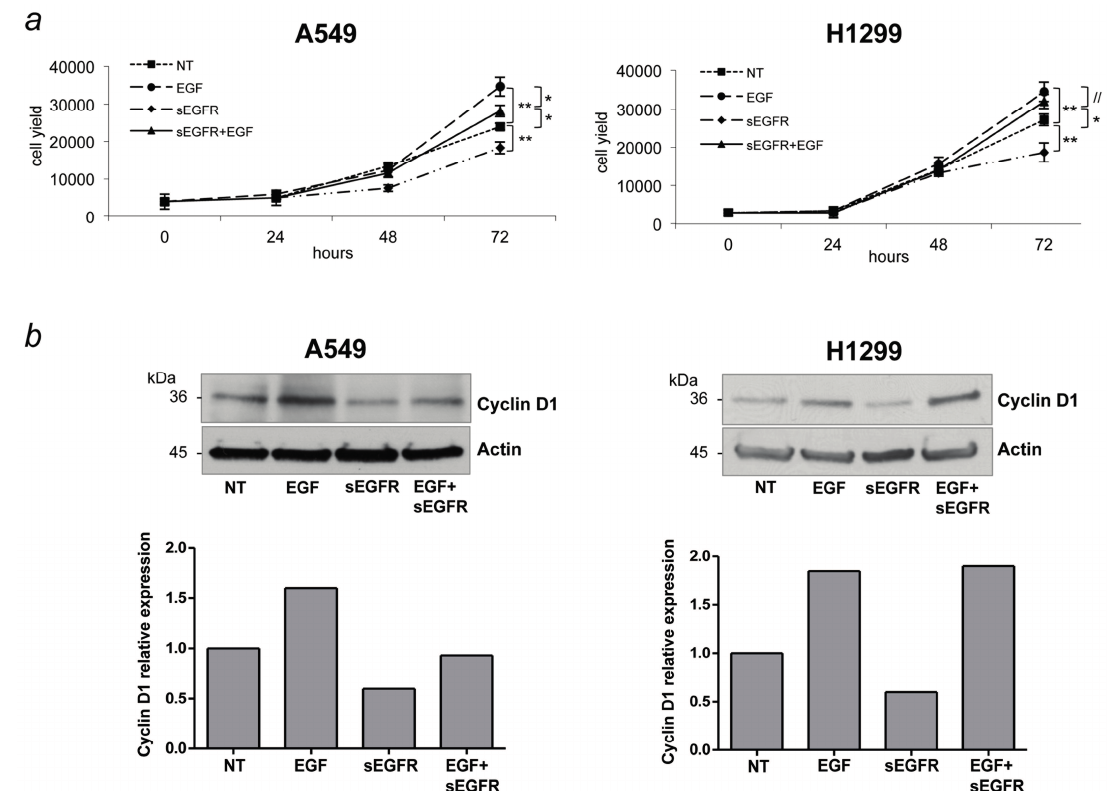
Figure 3. Effects of combined treatment with sEGFR and EGF on cell proliferation. EGFR-wild type cell lines (A549 and H1299) were treated with sEGFR (1 µg/mL) and EGF (100 ng/mL) alone and in combination (EGF + sEGFR). ( a ) Graph shows cell numbers at the indicated times after treatments. Untreated (NT) cells were used as a negative control. Asterisks indicate significant differences ( * p < 0.05, ** p < 0.01, // p not significant) when comparing NT cells with: sEGFR, EGF, and sEGFR + EGF treatments. p value was also calculated for EGF-treated cells and those treated with EGF + sEGFR. Data are means ± SD from experiments with three replicates; ( b ) Western blot analysis of cyclin D1 expression levels in A549 and H1299 cell lysates obtained 24 h after treatment with sEGFR (1 ug/mL). β -actin was used as a loading control. The lower panels show cyclin D1 expression levels normalized to β